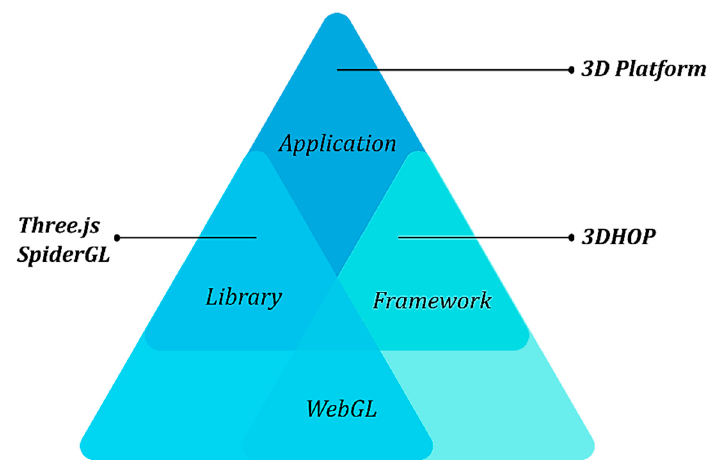
Figure 2. Structural schema of the visualization tools of the application.